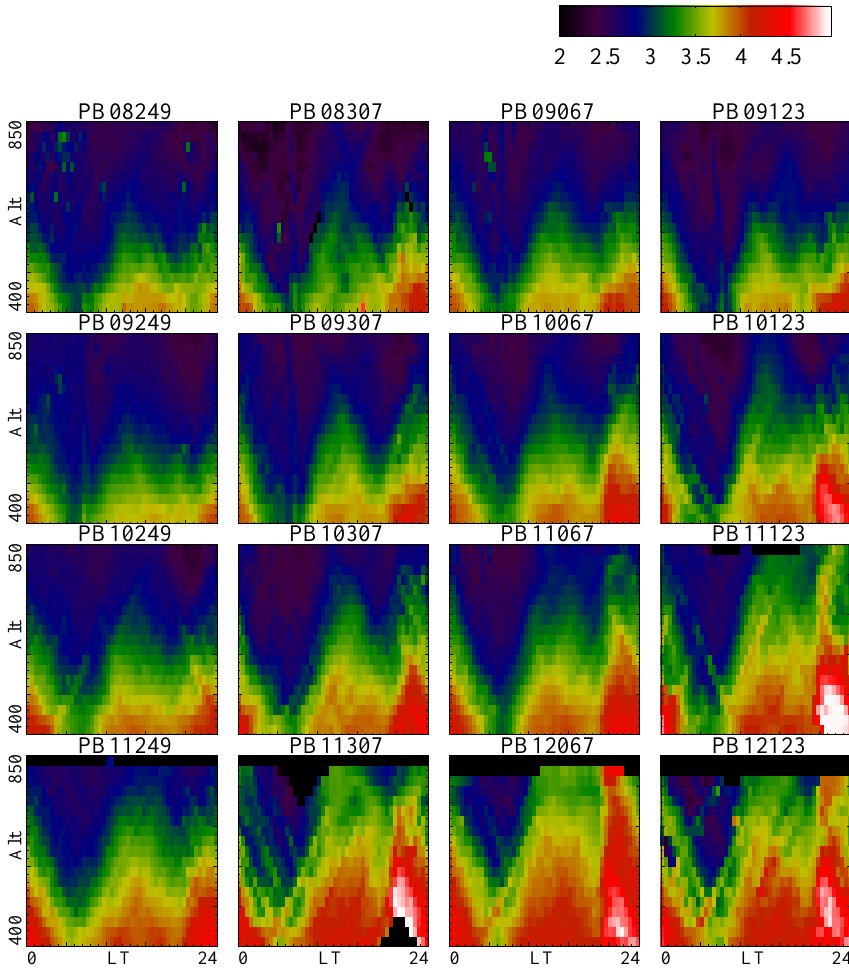
Fig. 8. Climatology of plasma density irregularities as a function of altitude and local time (LT), integrated over all longitudes and averaged over seasons from (Northern Hemisphere) summer 2008 (upper left) to spring equinox 2012 (lower right). The density scale is logarithmic, ranging from 10 2 to 10 5 cm − 3 for the density